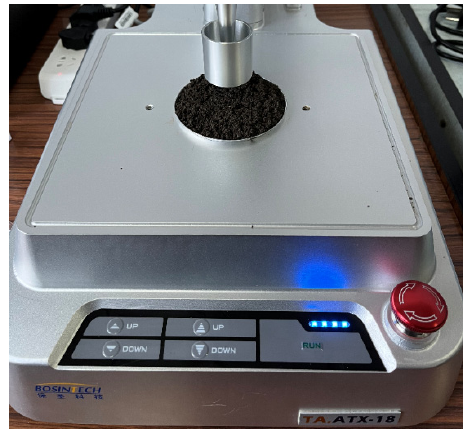
Figure 12. Texture analyzer.